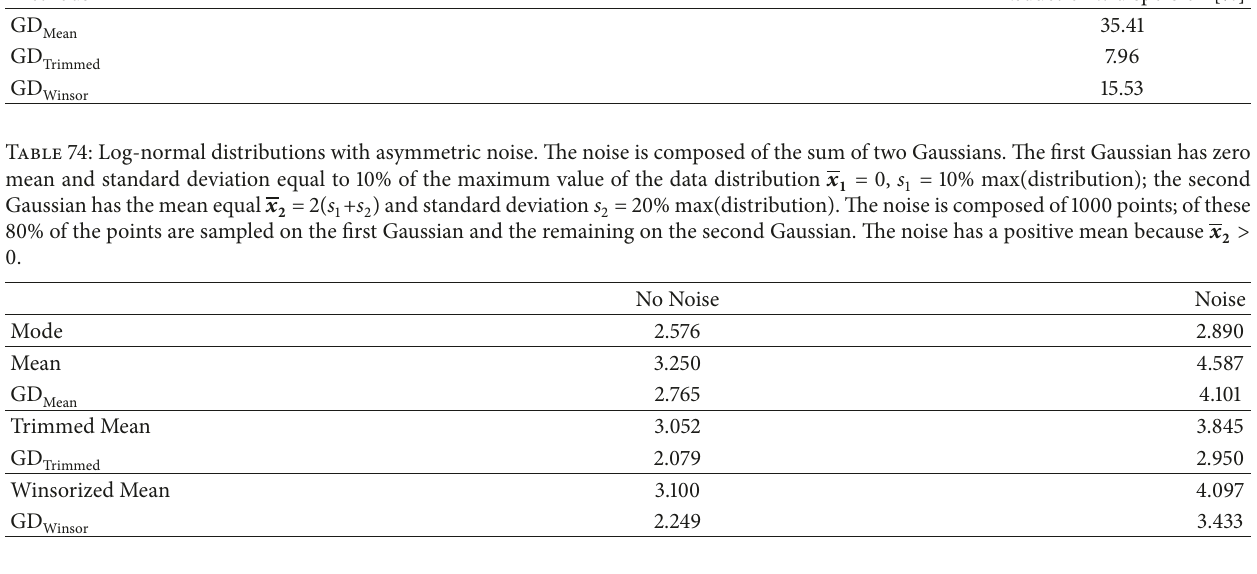
Table 75: Log-normal distributions with asymmetric noise. The noise is composed of the sum of two Gaussians. The first Gaussian has zero mean and standard deviation equal to 10% of the maximum value of the data distribution 𝑥 1 = 0, s 1 = 10% max(distribution); the second Gaussian has the mean equal 𝑥 2 = -2(s 1 +s 2 ) and standard deviation s 2 = 20% max(distribution). The noise is composed of 1000 points; of these 80% of the points are sampled on the first Gaussian and the remaining on the second Gaussian. The noise has a negative mean because 𝑥 < 0. 2